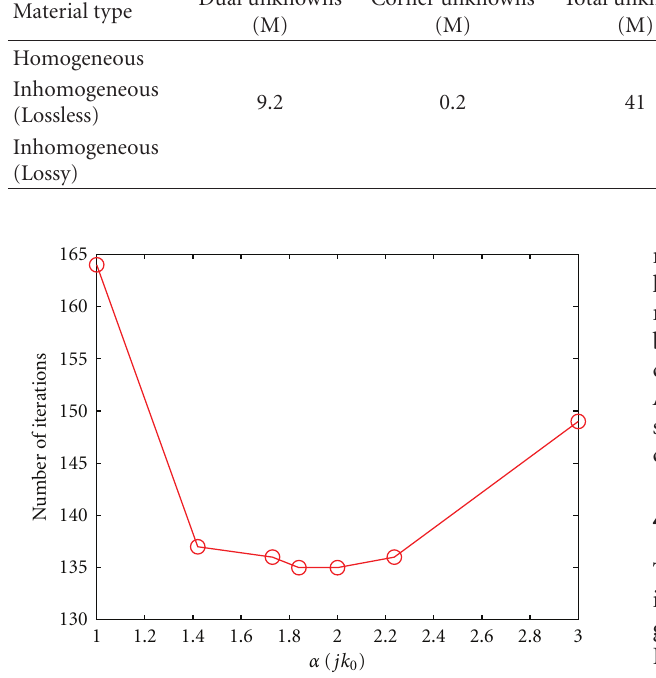
Figure 6: Iteration number for the brick versus di ff erent α .